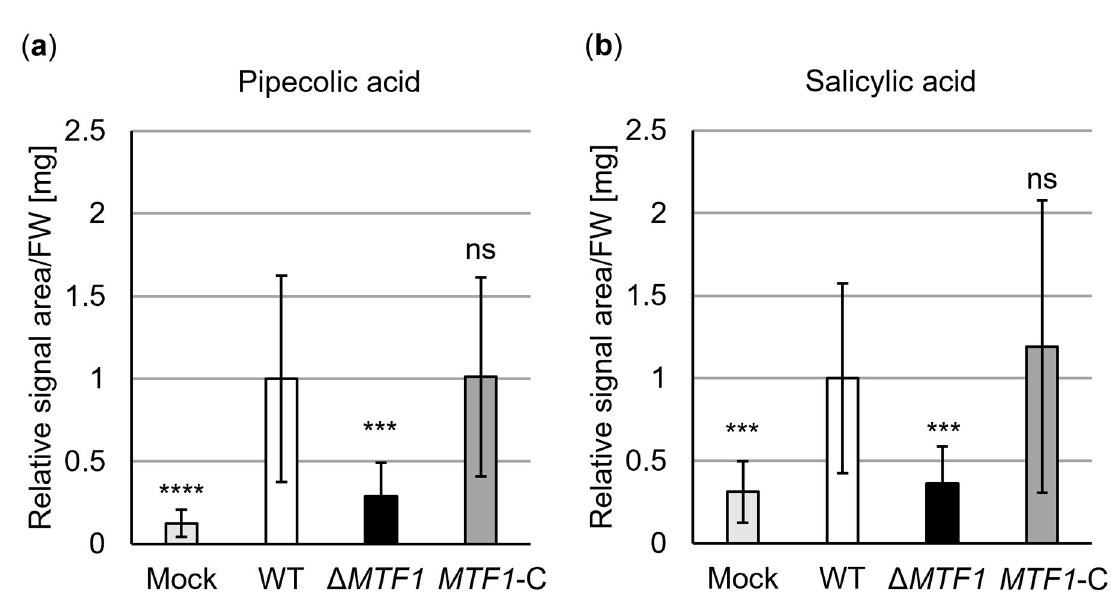
Fig 10. The levels of (a) pipecolic acid and (b) salicylic acid in tomato leaves are elevated after infection with wild-type Verticillium dahliae but not after inoculation with MTF1 deletion strains. Phytohormones were analyzed in leaves 21 days after root treatment with water (mock) or spores of indicated strains. The relative signal area per fresh weight (FW) was calculated and normalized to wild-type (set to one). Means of 15 plants per treatment from two independent experiments are shown with error bars representing SD. Significant differences from wild-type (WT) were determined using t -tests. Plant infection by wild-type or MTF1 complementation ( MTF1 -C) strains led to the induction of pipecolic acid and salicylic acid levels compared with mock, whereas treatment with spores of the MTF1 deletion strain ( Δ MTF1 ) resulted in mock-like phytohormone levels that were significantly lower compared with wild-type (ns, not significant; �� , P < 0.01; ��� , P < 0.001; ���� , P <